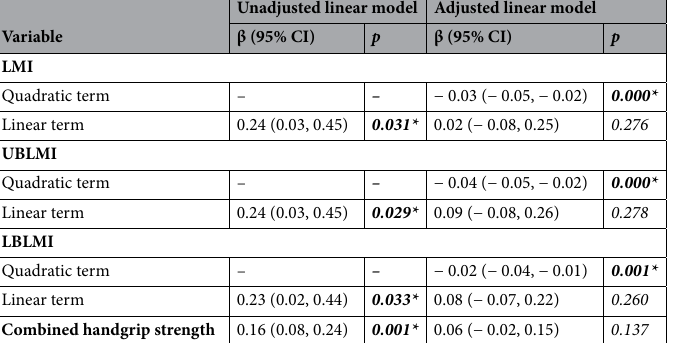
Table 3. Standardised linear effect of free androgen index (FAI) on lean mass index (LMI), upper body lean mass index (UBLMI), lower body lean mass index (LBLMI) or combined handgrip strength in 18–40-year-old females (n = 716). *denotes statistical significance ( p < 0.05).